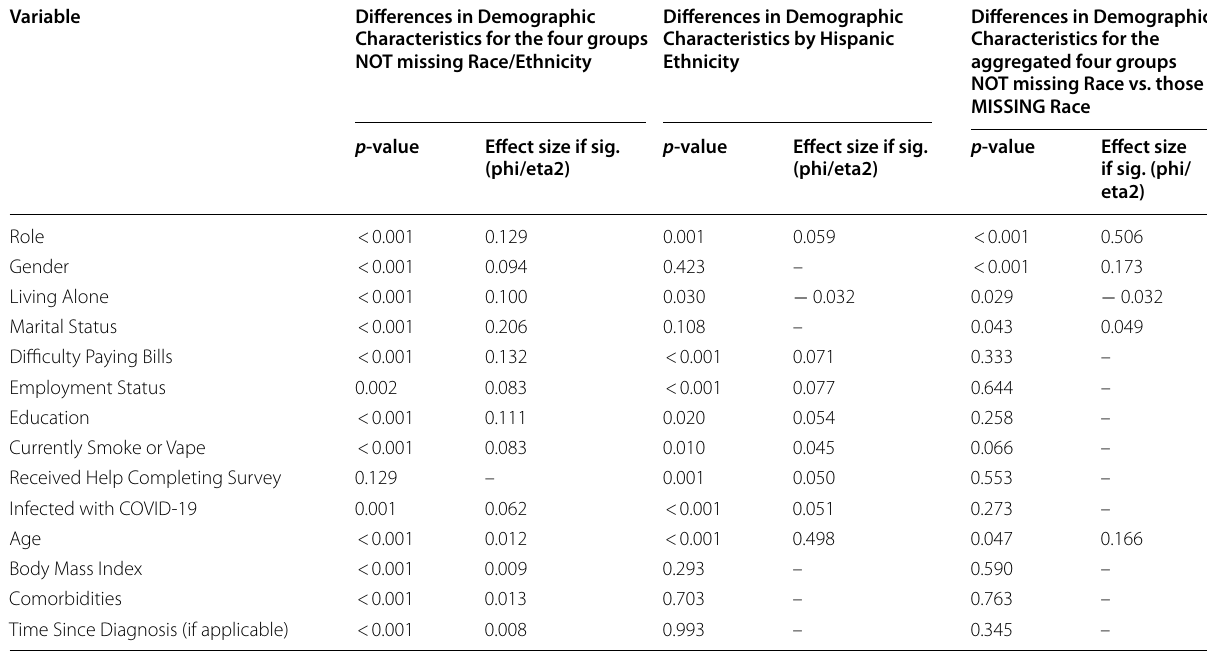
Table 2 Sample Demographic Characteristics ( N